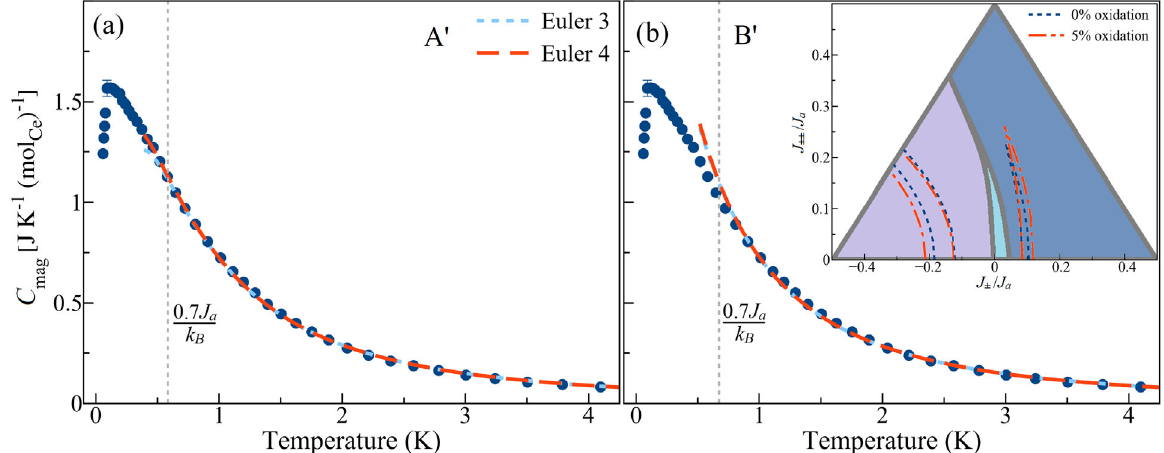
FIG. 13. (a) The results of the fourth-order NLC C calculation for 5% sample oxidation, using the near-neighbor exchange mag 0 . 067 meV, J 0 . 067 meV, and J 0 . 012 meV (set A 0 ), overlaid on top of the measured C parameters J a ¼ b ¼ c ¼